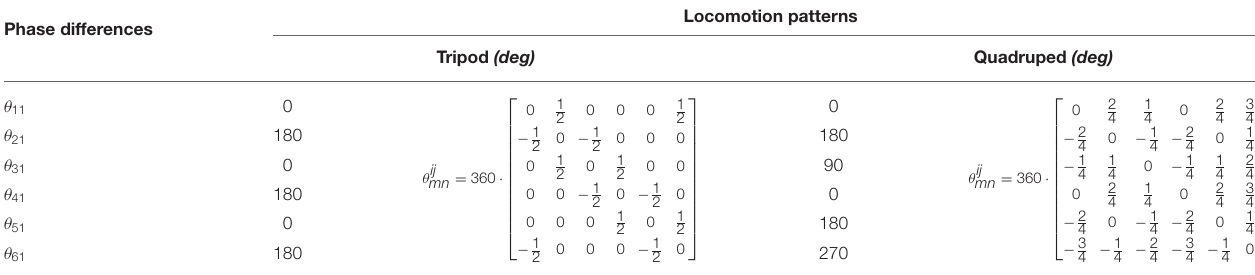
TABLE 4 | Phase differences in corresponding locomotion. Phase